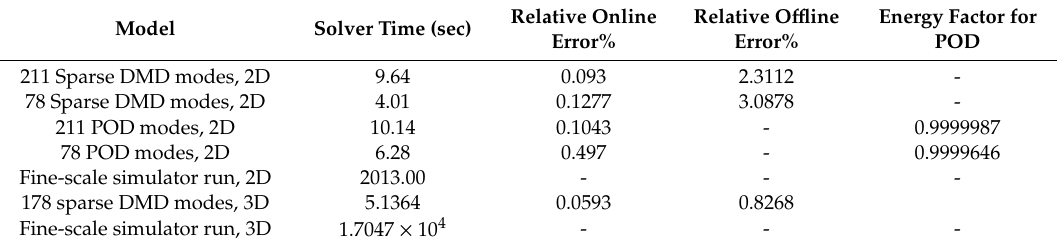
Table 3. Relative error of pressure and velocity between high fidelity and reduced model.